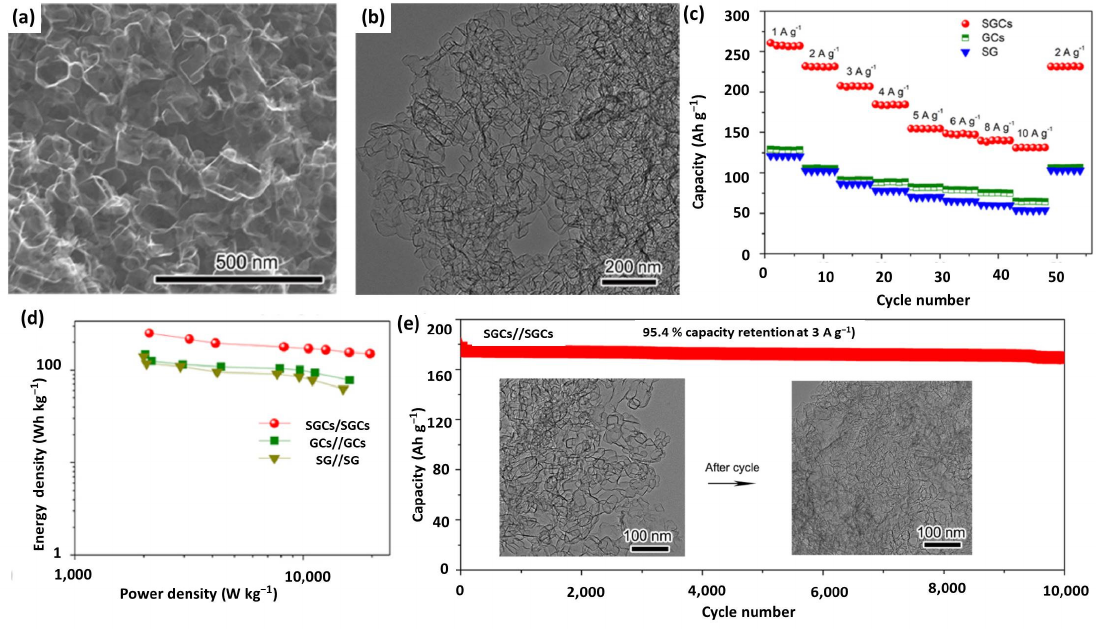
Figure 5. ( a ) SEM and ( b ) TEM images of SGCs; ( c ) Rate performance of SGCs cathode, compared with GCs and SG; ( d ) Ragone plots of SGCs//SGCs, compared with GCs//GCs and SG//SG; ( e ) Cyclic performance of SGCs//SGCs (the insets are the before and cycled TEM images of